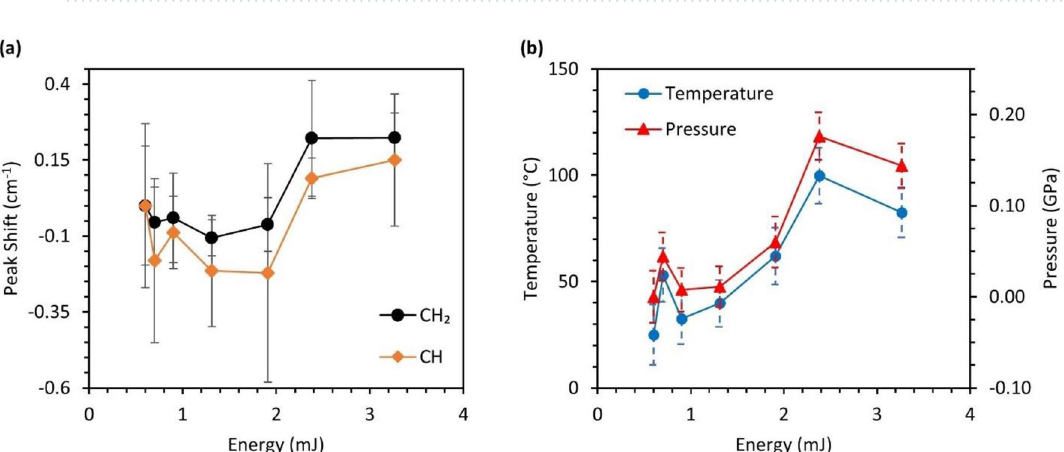
Figure 3. Analysis of the mechanical and thermal effects on sucrose with an increase in probe pulse energy where ( a ) shows the change in Raman shift of CH 2 and CH functional group in sucrose with laser pulse energy and ( b ) shows the predicted pressure and temperature rise in sucrose crystal with laser pulse energy (20 ns at 10